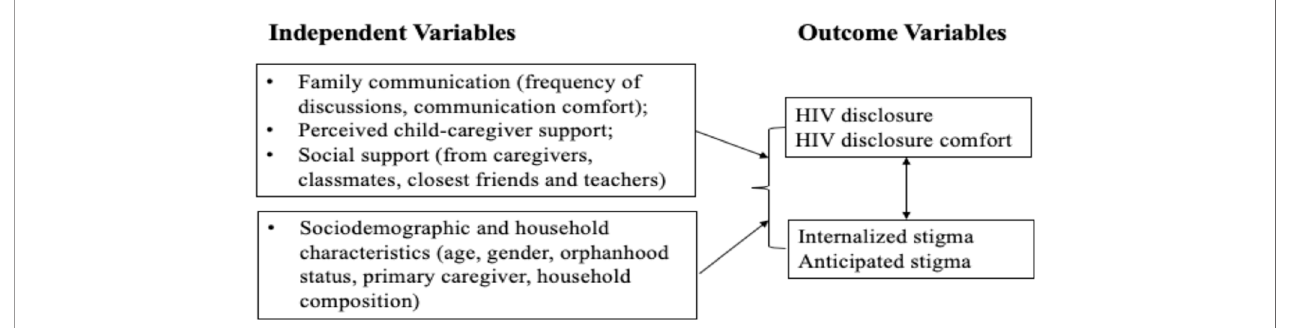
FIGURE 1 | Conceptual